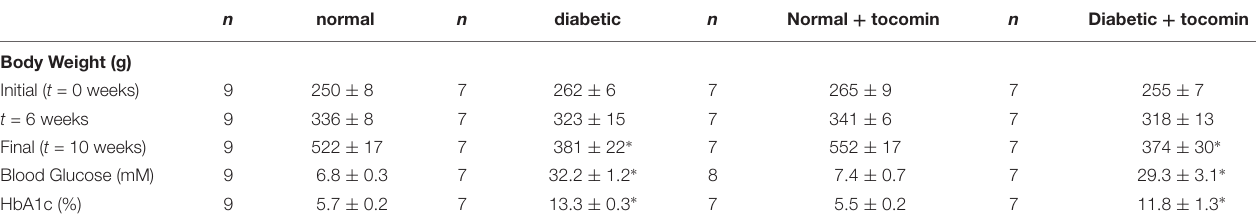
TABLE 1 | Mean body weight, fasting blood glucose, and HbA1c levels for normal and diabetic treatment groups. n normal n diabetic n Normal + tocomin n Diabetic + tocomin